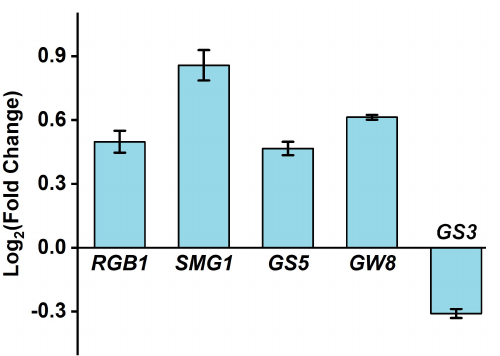
Figure 2. The results of gene expression in (young panicles) at the filling stage (5 September 2020) show that HNW may increase rice seed size. Then, transcripts of RGB1 , SMG1 , GS5 , GW8 , and GS3 were analyzed by qPCR. Data are mean ± SD (n = 3).